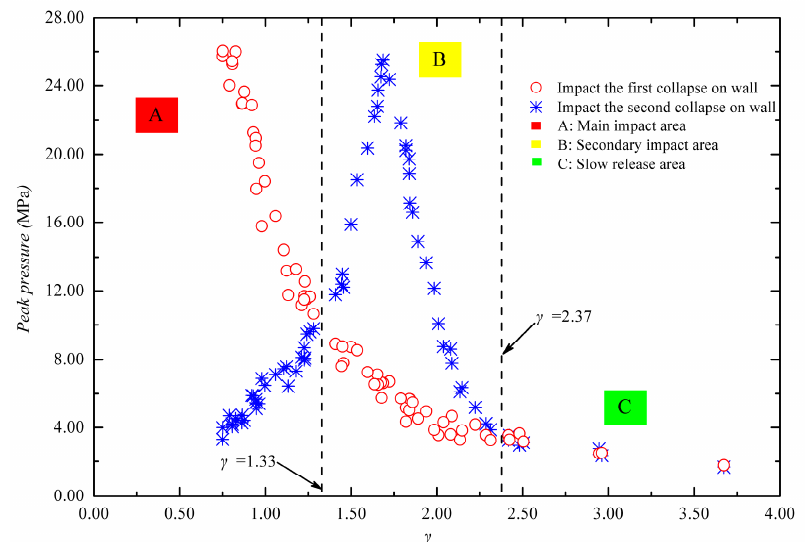
Figure 6. The relationship between the dimensionless distance ( γ ) and the wall peak pressure.